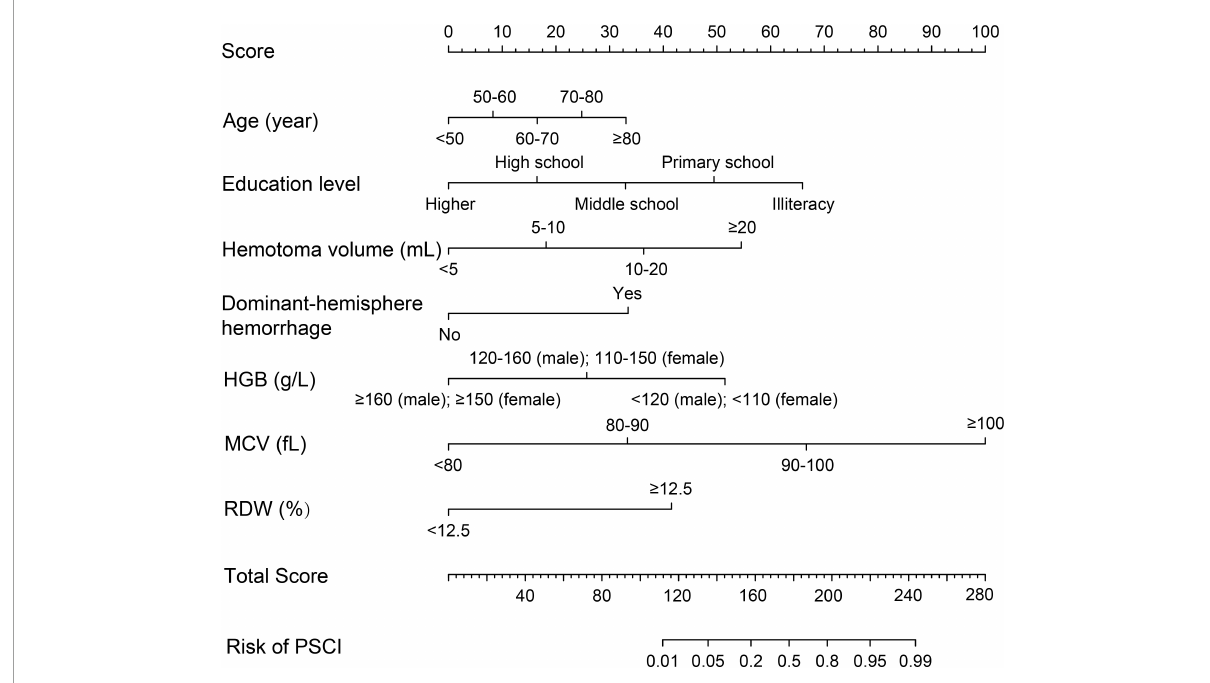
FIGURE2 Prognostic nomogram for PSCI in ICH patients. The value of an individual patient is located on each variable axis, and a line is drawn upward to the “Score” axis to determine the corresponding score received for each variable value. The total score is calculated by adding each score of the seven variables included in the nomogram, and a line is drawn from the “Total Score” axis downward to the “Risk of PSCI” axis to determine the likelihood of PSCI.